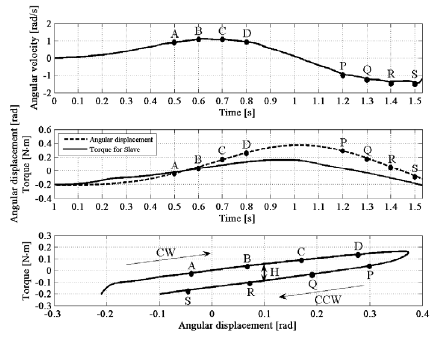
Fig. 9 Slow cooperative motion Fig. 10 Quick cooperative